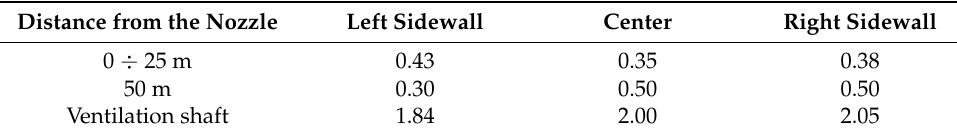
Figure 8. The distribution of the air volume flow in the excavation adopted in the numerical model. Table 4. Values of air velocity in the examined excavation.